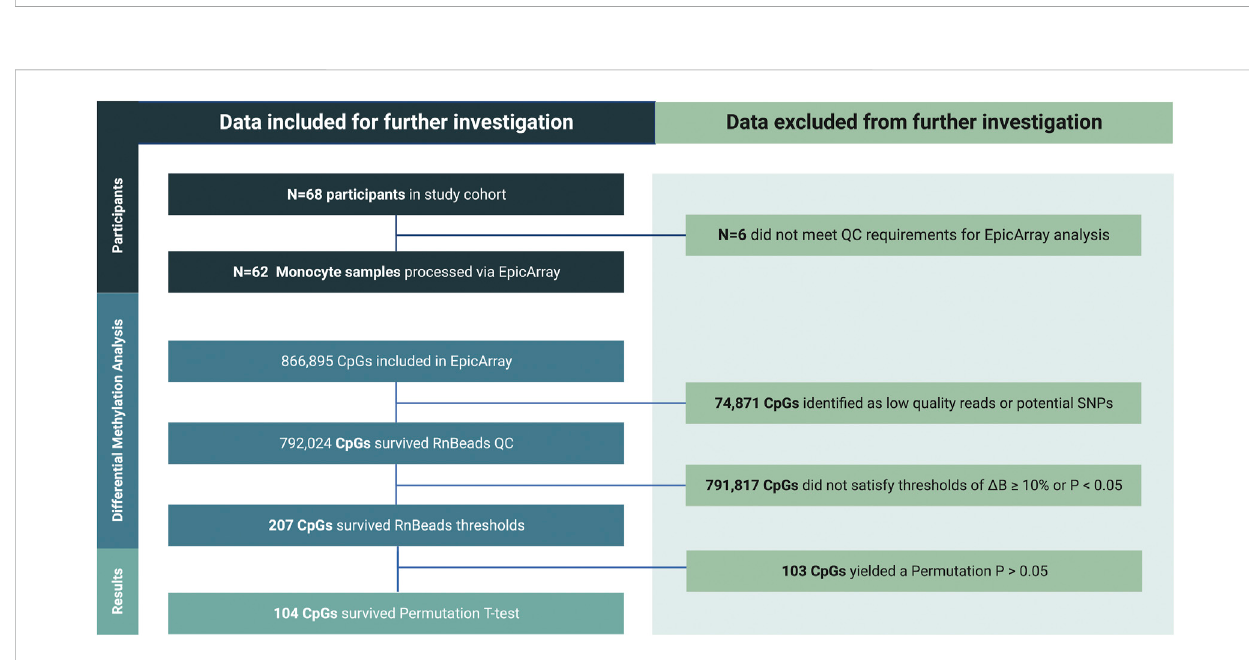
FIGURE 4 Inclusion-exclusion criteria utilized to determine the fi nal set of differentially methylated loci (DML) upon SE strati fi cation for downstream analyses. Of the ~850,000 CpG sites considered on the standard In fi nium MethylationEPIC Array, those possessing a mean Δ β of < 10% between NSE and LSE groupsand/ora p -valueof > 0.05duringRnBeadsdifferentialmethylationanalysiswereeliminatedforconsiderationamongdifferentiallymethylatedloci (DML). Surviving CpG sites were further evaluated via Empirical Bayes permutation t -test between NSE and LSE